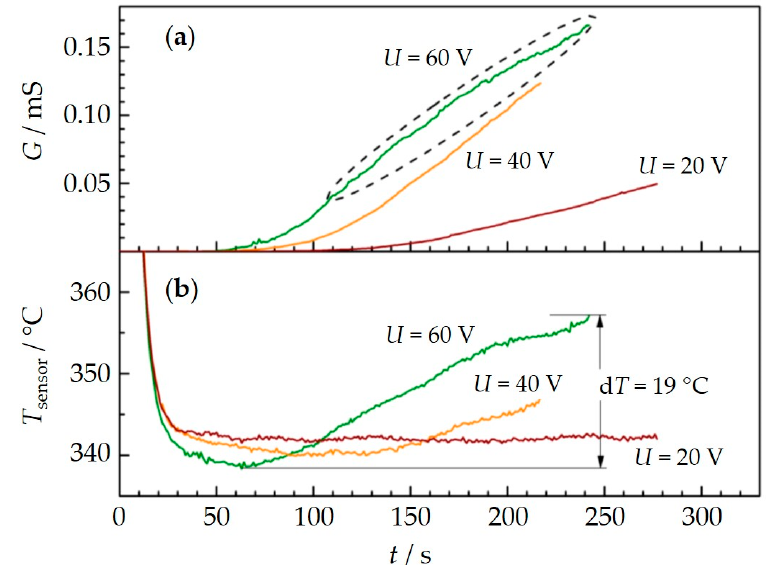
Figure 6. Conductance over time during soot deposition for three cycles with different voltages U IDE between the sensing electrodes ( a ) and corresponding sensor temperature determined by the reverse side platinum meander element ( b ). The engine operation point was kept constant during the experiment (soot concentration = 30 mg/m 3 ).